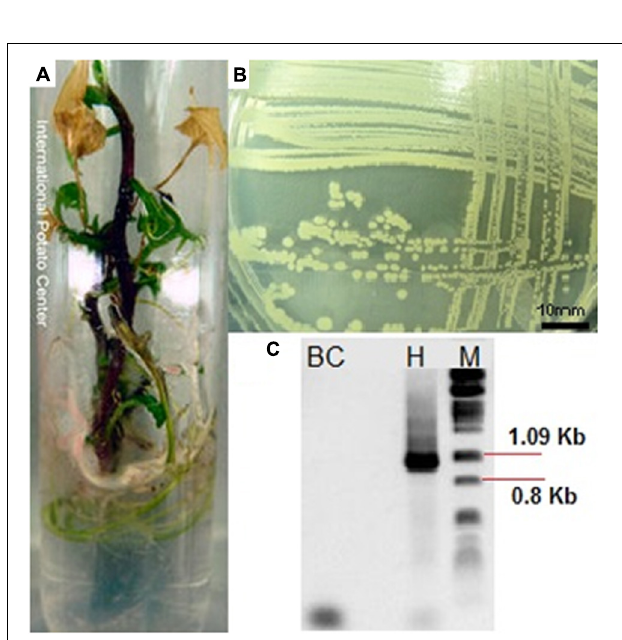
FIGURE 2 | (A) In vitro sweetpotato accession (CIP 420613) showing signs of bacterial contamination, (B) an example of morphology of isolated bacteria, and (C) PCR amplification of 16S rDNA gene segments with primers pA and pF (1,066 bp) [BC, background Control, H: PCR amplification of the bacteria, M: molecular weight marker (lambda phage DNA digested with Pst